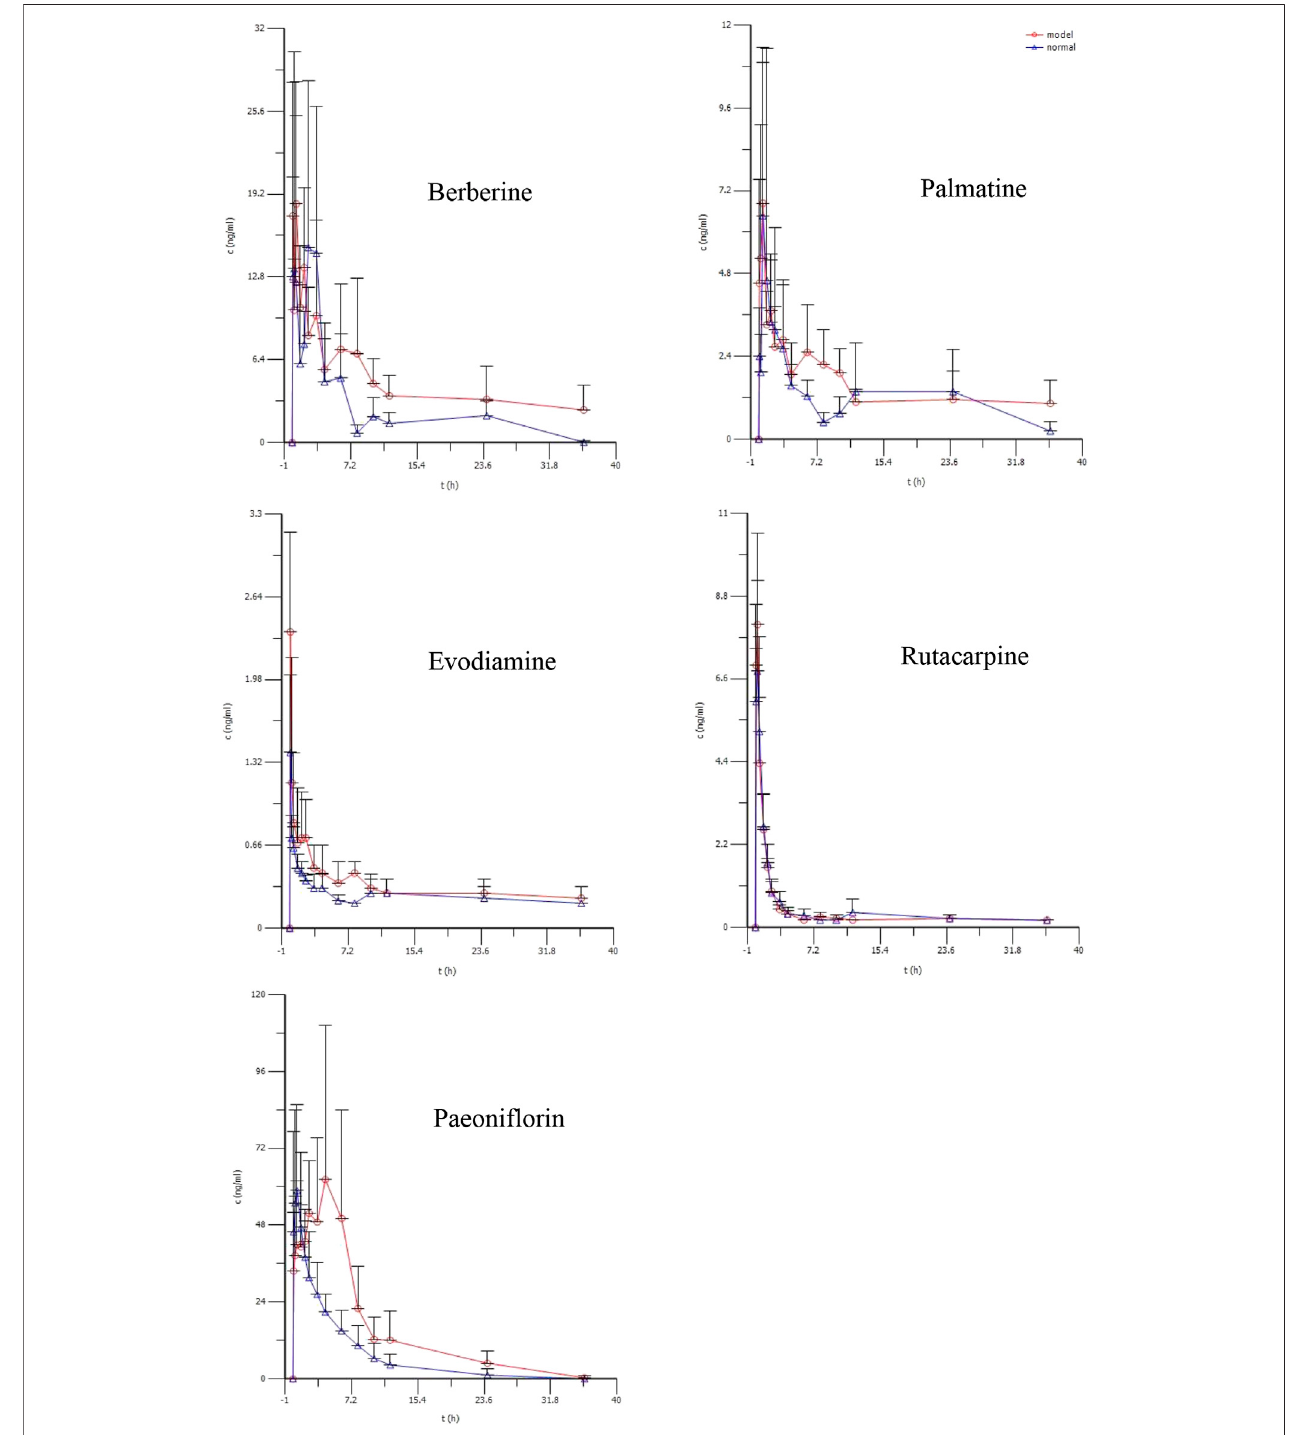
FIGURE3| Themean plasmaconcentration(ng/ml)ofberberine, palmatine,Evodiamine,rutacarpine, and paeoni fl orin vs. time(h)pro fi les after single doses oforal administration of WJW Extract (629.6 mg/kg) with the equivalent dose of 88.4 mg/kg, 21.1 mg/kg, 0.22 mg/kg, 0.28 mg/kg, 25.1 mg/kg for berberine, palmatine, evodiamine, rutacarpine, and paeoni fl orin respectively in normal and CVH-IBS model rats. Values were expressed as mean ± SD ( n = 5).